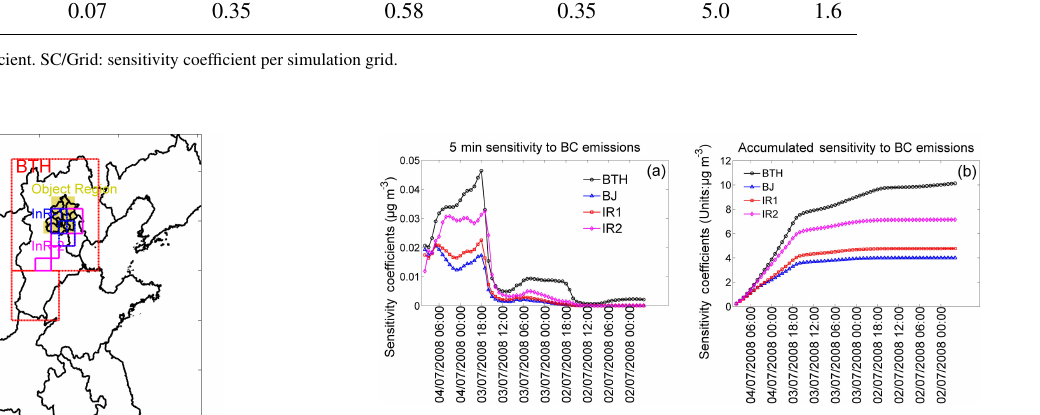
Figure 8. (a) Sensitivity coefficients at each 5min integration time step along inverse time sequence; (b) cumulative sensitivity coeffi- cients along inverse time